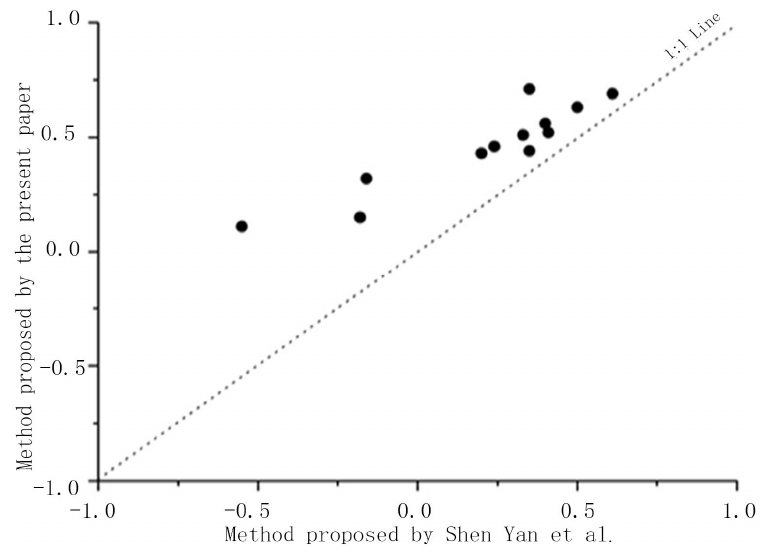
Figure 4. Coefficient of efficiency (CE) of the two fusion methods in region C1 in July 2009.